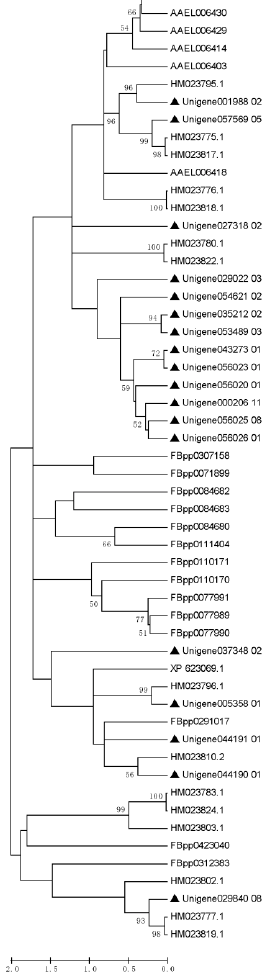
Figure 5. The phylogenetic analysis of seminal fluid trypsins among different insect species. The phylogenetic tree was constructed by the maximum likelihood method and the Jones–Taylor–Thornton (JTT) substitution model using deduced amino acid sequences of the conserved domains of seminal fluid trypsin. The phylogeny was tested with 1000 bootstrap replications using the bootstrap method. Sequences beginning with “Unigene” represent transcriptome unigene IDs of Plutella xylostella seminal fluid trypsins, indicated by the black triangle. Sequences beginning with “FBpp” represent IDs of Drosophila melanogaster seminal fluid trypsins (http://flybase.org/, accessed on 23 January 2023). Sequences beginning with “AAEL” represent IDs of Aedes aegypti seminal fluid trypsins (http://www.vectorbase.org/, accessed on 23 January 2023). Sequences beginning with “XP” represent IDs of Apis mellifera seminal fluid trypsins (http://www.ncbi.nlm.nih.gov/, accessed on 23 January 2023). Sequences beginning with “HM” represent IDs of Heliconius erato and H. melpomene seminal fluid trypsins (http://www.ncbi.nlm.nih.gov/, accessed on 23 January 2023). Considering that not all secreted ACPs may be transferred from males to females during mating, we analyzed the proteins that contained signal peptides, but were not detected from mated-CB samples. Eight proteins met the above criteria, and their information, including nucleic acid sequences and the corresponding amino acid sequences, are listed in Table S7.